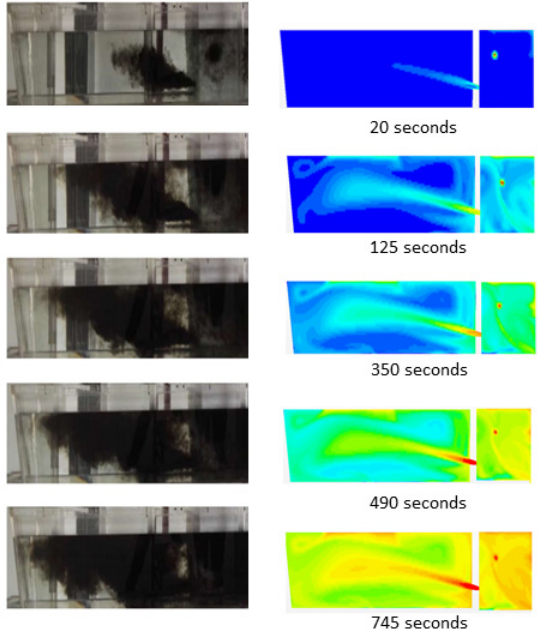
Figure 6. Tracer dispersion in Case 4—UB + TI in water modeling and numeric